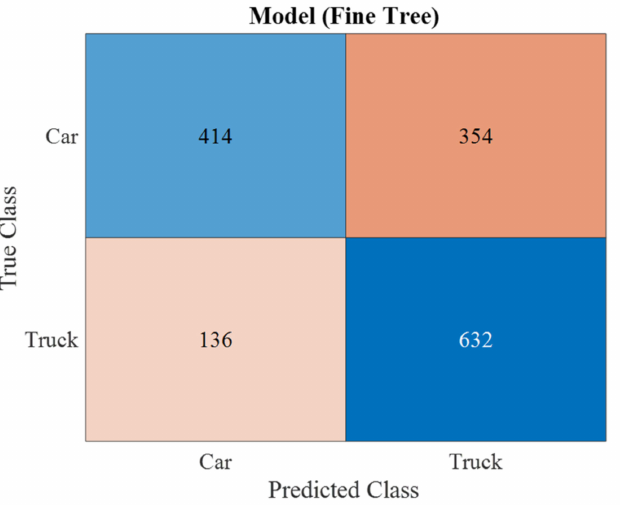
Figure 9. Confusion matrix for linear polarization (algorithm—fine tree (68%); split criterion—Gini’s diversity index).